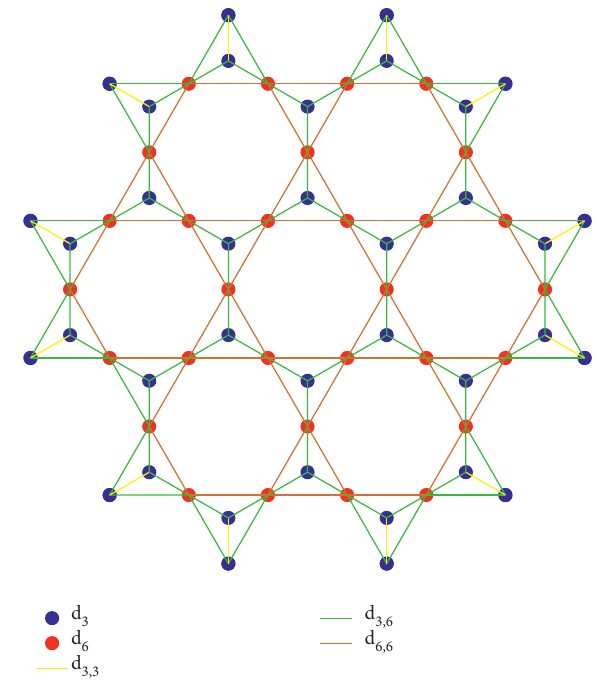
Figure 1: Chemical graph of silicate network ( SL Table 2: Vertex partition of SL